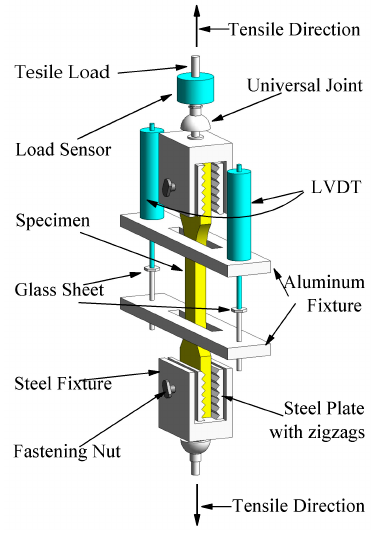
Figure 3. Schematic diagram of the loading device.